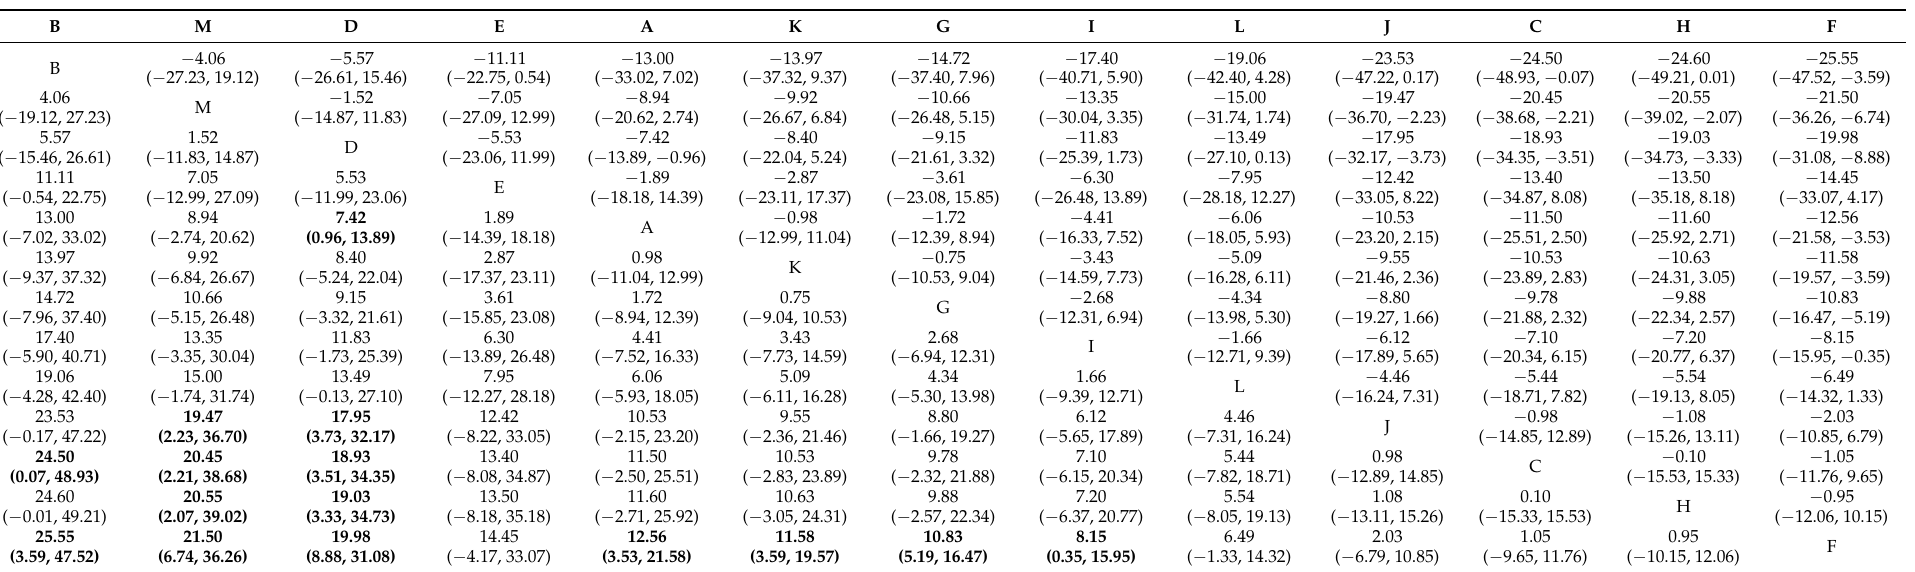
Table 5. Network analysis results of the repetition